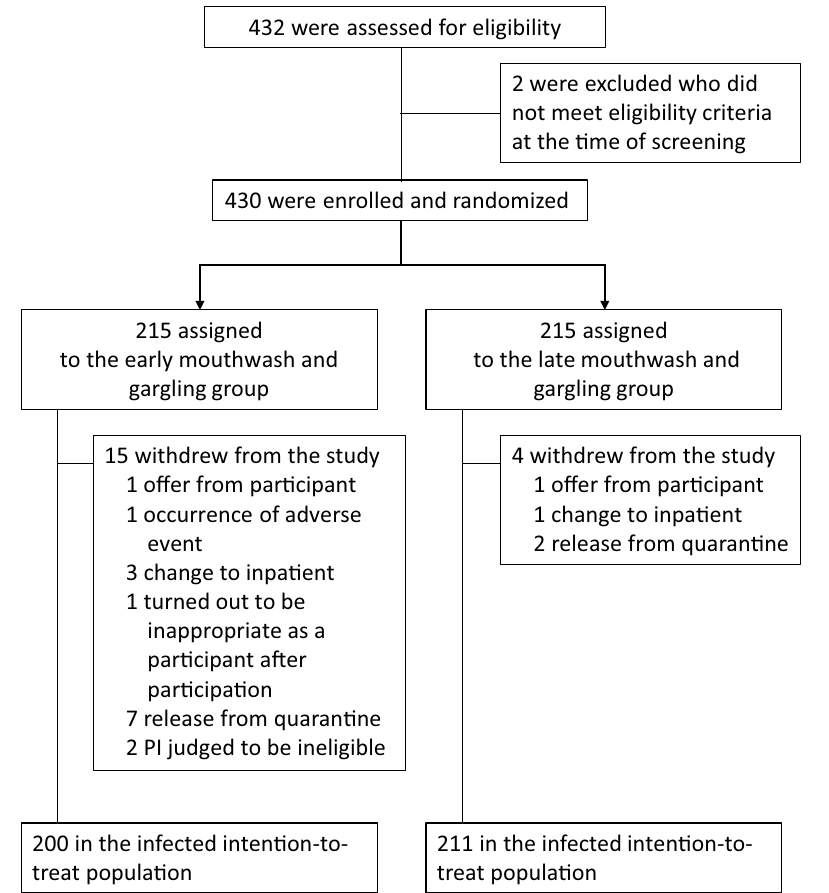
Figure 1. Patient enrollment and intervention